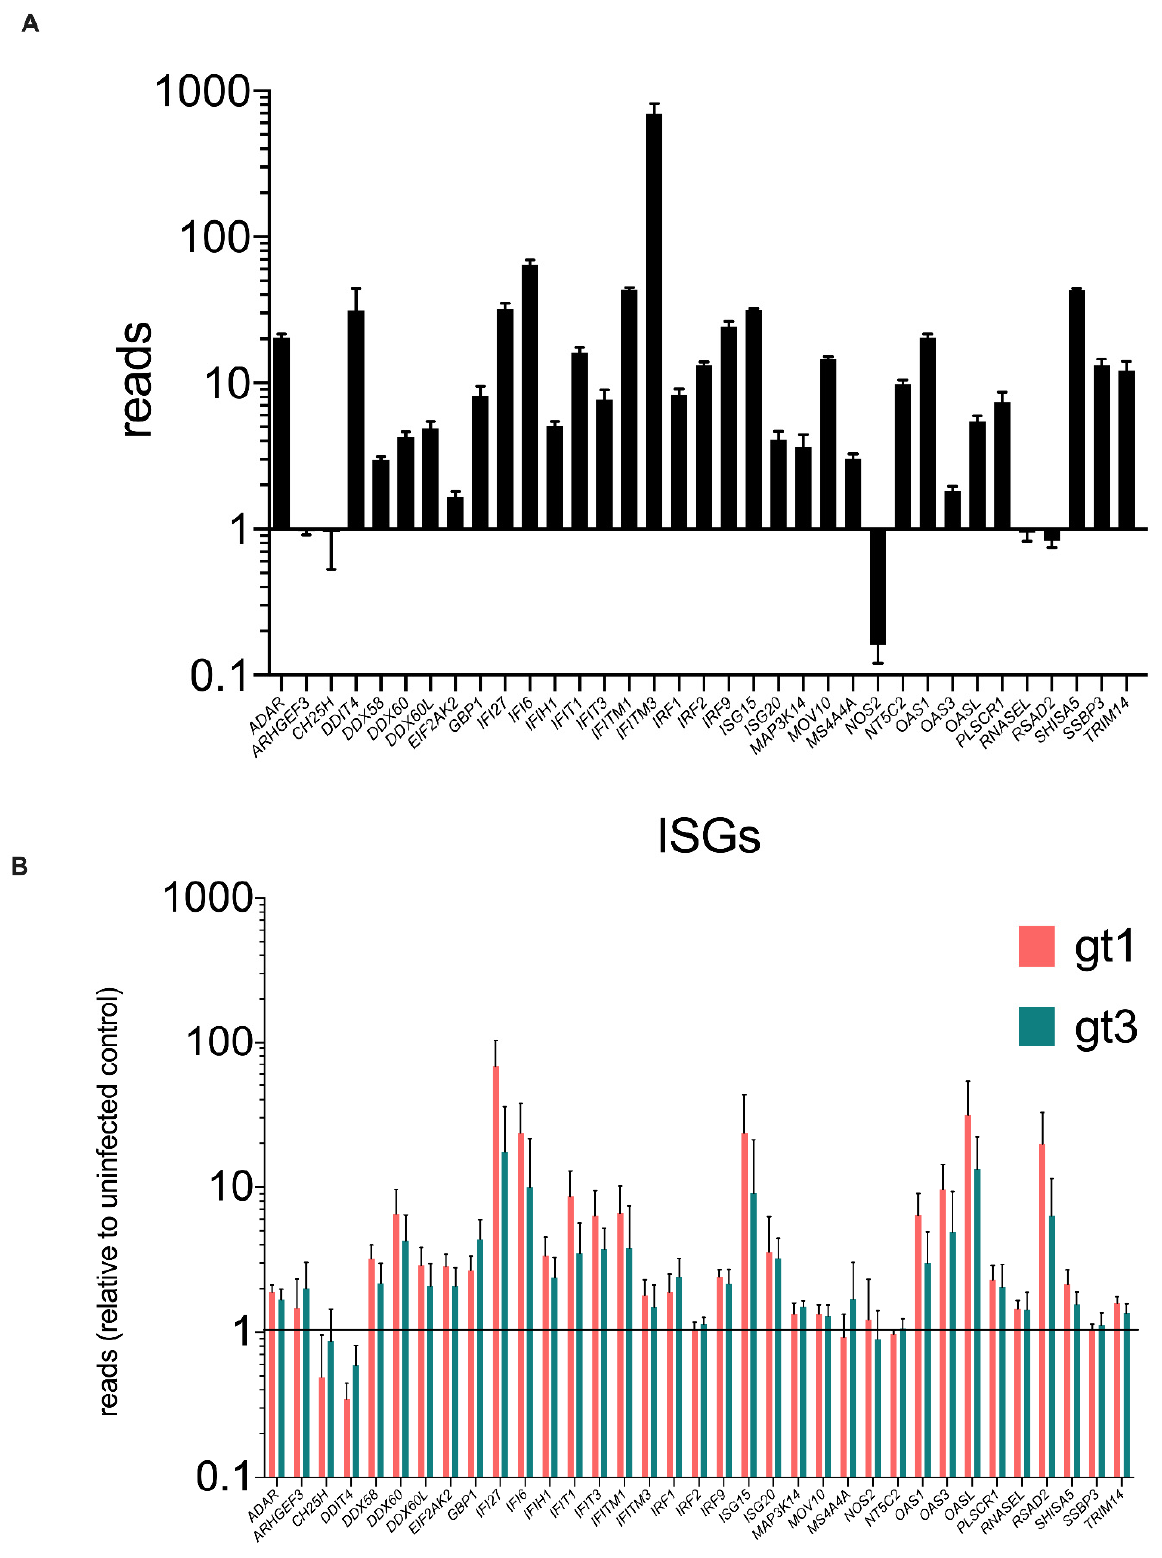
Figure 6. Abundance of ARHGEF3/XPLN RNA in vivo in HCV-infected human liver biopsies. RNA levels (FKPM) of known anti-HCV ISGs in liver biopsies from uninfected individuals ( n = 4) ( A ). Fold-change in RNA (FPKM) levels of known ISGs in liver biopsies from infected individuals (HCV gt1: pink; gt3: green (each n = 5)) compared to uninfected controls ( B ).